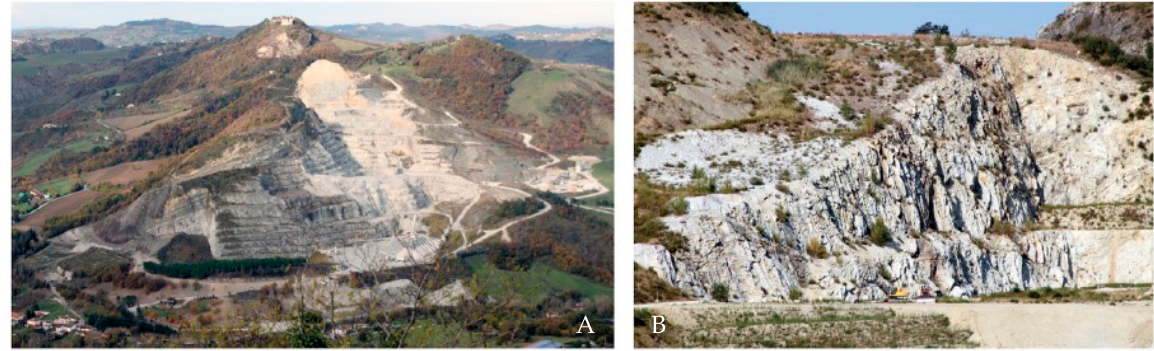
quarry; ( B ) Mt. Ceti quarry.